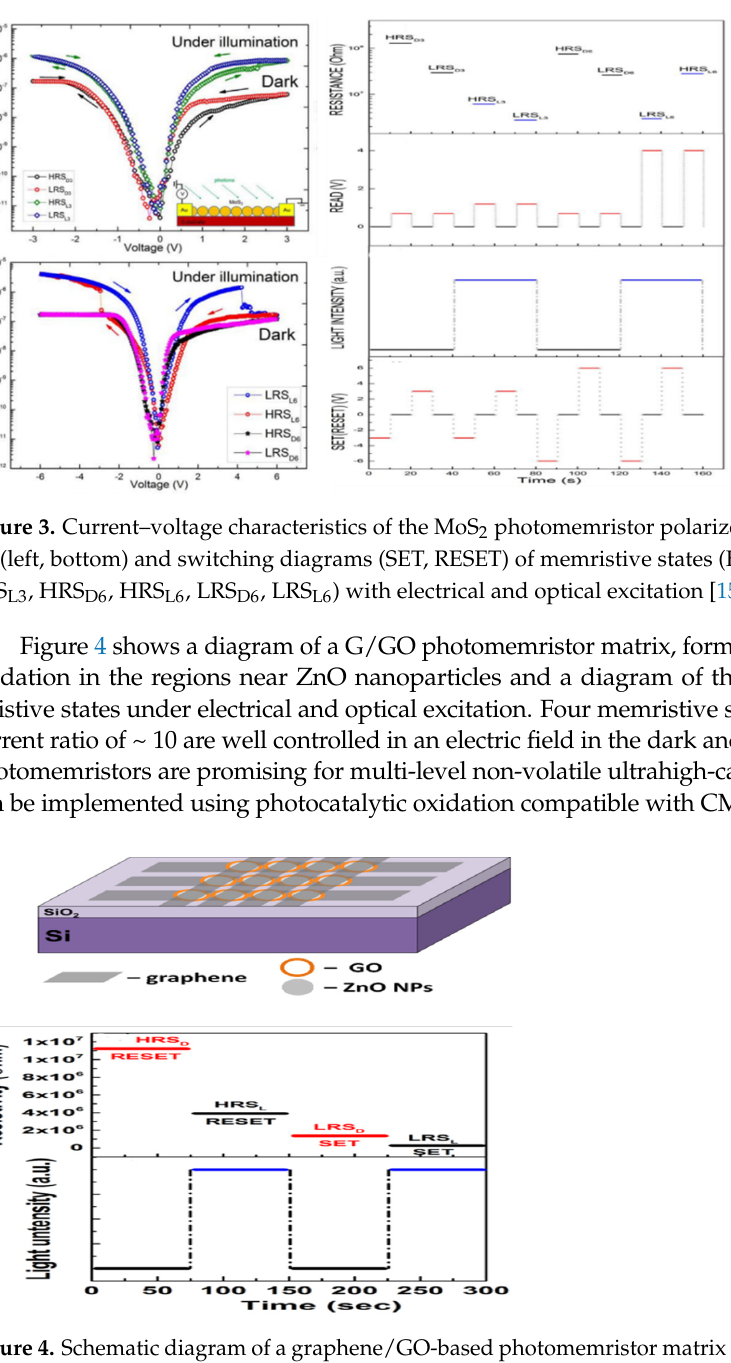
Figure 5. Spectral sensitivity of photodetectors made of 2D layered materials at 300 K. The black line shows the spectral sensitivity of an ideal photodiode with 100% QE and g = 1. The sensitivity of commercially available photodetectors (InGaAs and HgCdTe photodiodes) is presented for com- parison [21]. The uniqueness of the atomic surface of 2D materials without dangling bonds allows crystals to be embedded in CMOS technology without introducing structural defects, which makes it possible to produce high-quality functional integrated circuits for broad- band detection. CMOS-integrated circuits, which are at the heart of the microelectronics technologi- cal revolution, enable the creation of compact and inexpensive microelectronic circuits and imaging systems. However, the use of this platform in applications other than micro- circuits and visible light cameras is hampered by the difficulty of combining non-silicon semiconductors with CMOS technology. Monolithic integration of a CMOS-integrated cir- cuit with graphene acting as a high-mobility phototransistor was demonstrated in 2017 [22]. The high-resolution CMOS broadband image sensor can be used as a digital camera that is sensitive to ultraviolet, visible, and infrared light. The demonstrated graphene- CMOS integration is critical for incorporating 2D materials into next-generation microe- lectronics, sensor arrays, low-power integrated photonics, and CMOS imaging systems